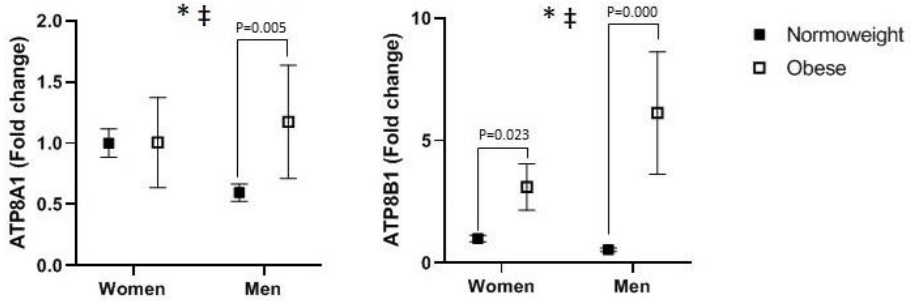
Figure 1. Visceral adipose tissue expression levels of ATP8A1 and ATP8B1 in women and men as a function of obesity. Data are expressed as means ± SEM and were submitted to multivariate and univariate general linear models introducing groups of subjects and obesity as independent variables. * p < 0.05 for the significant difference between normal-weight and obese subjects. ‡ p < 0.05 for the difference between the interaction of obesity and sex.